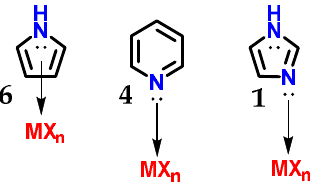
Figure 9. Complex with transition metals η 5 ( π ) carried out by pyrrole 6 and the complexes η 1 ( σ ,N py ) carried out by imidazole 1 and pyridine 4 .